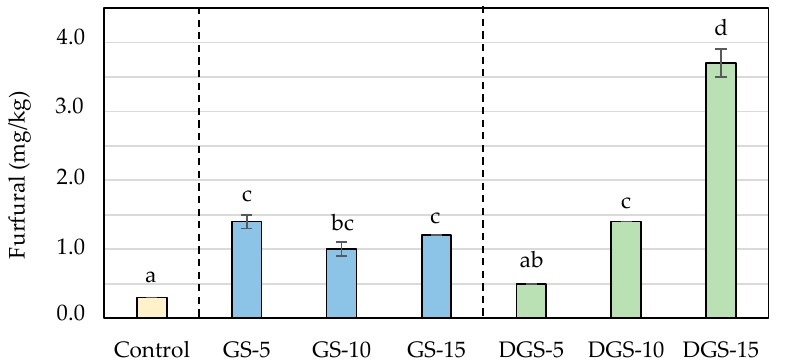
Figure 3. HMF (mg/kg) concentrations in wheat-based biscuits (control) with added ground chia seeds (GS) and defatted ground chia seeds (DGS) at 5, 10 and 15%. Values are mean ± standard deviation. Different letters mean significant differences ( p < 0.05).